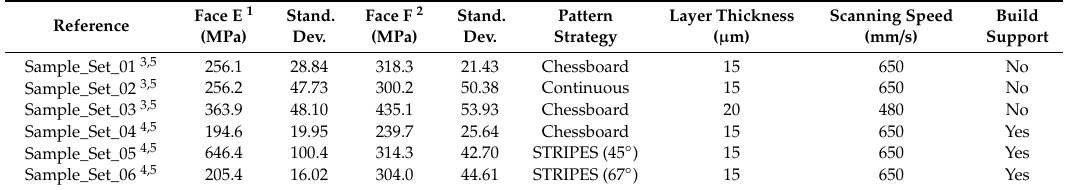
Table 7. Residual stress values of faces E and F found at approximately 2 θ = 78 ◦